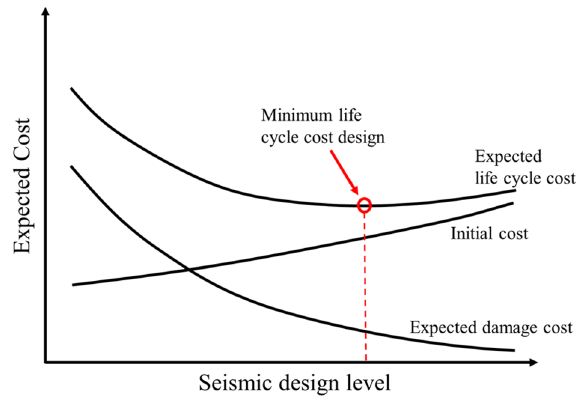
Figure 1. Illustration of the expected life cycle cost 10